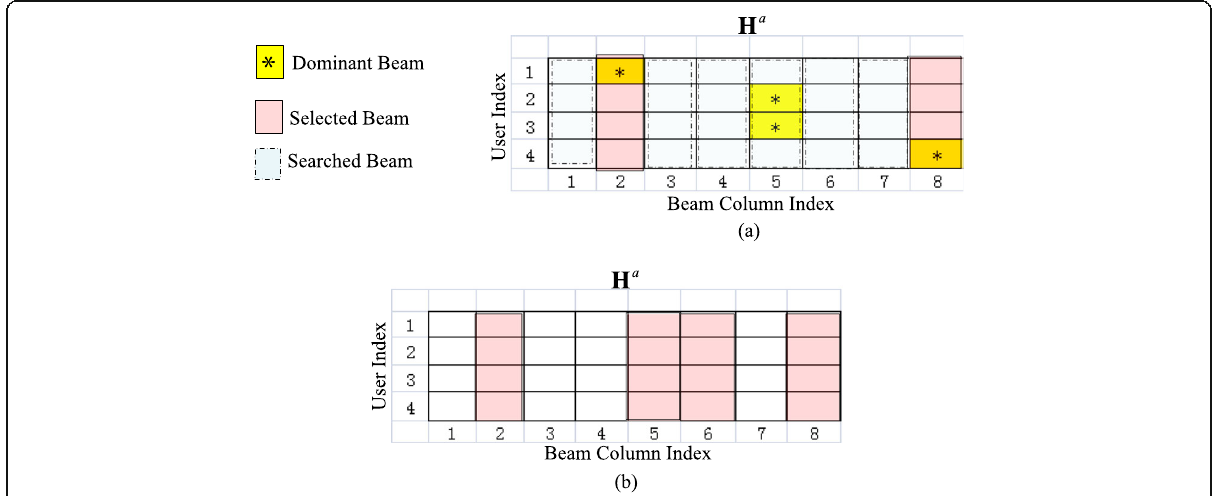
Fig. 2 An example of the CA beam-column selection method. a Stage 1: Grouping stage to identify CUs and NCUs. b Stage 2: Best beam searching